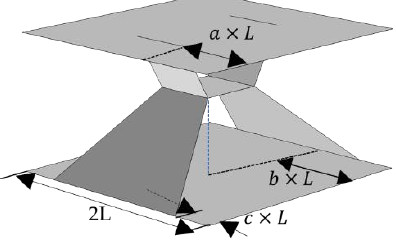
Figure 7. Geometry for one cell of the shape optimization model.